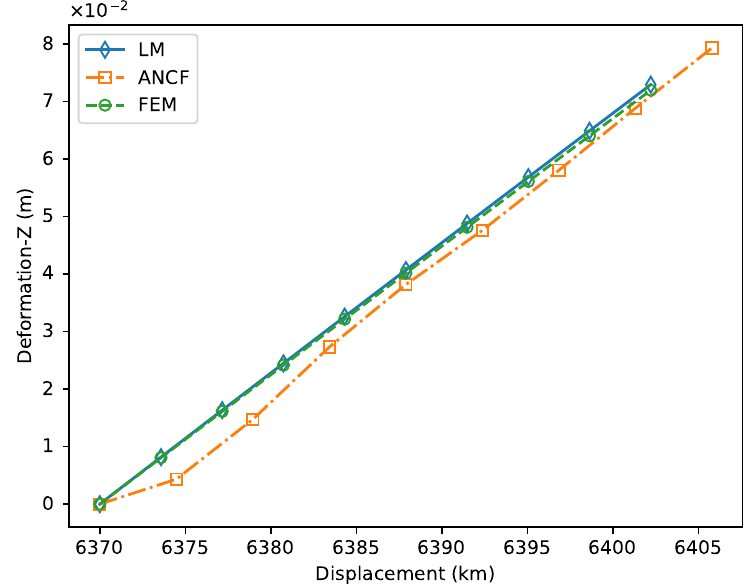
Figure 12. Deformation Z close to the ground.